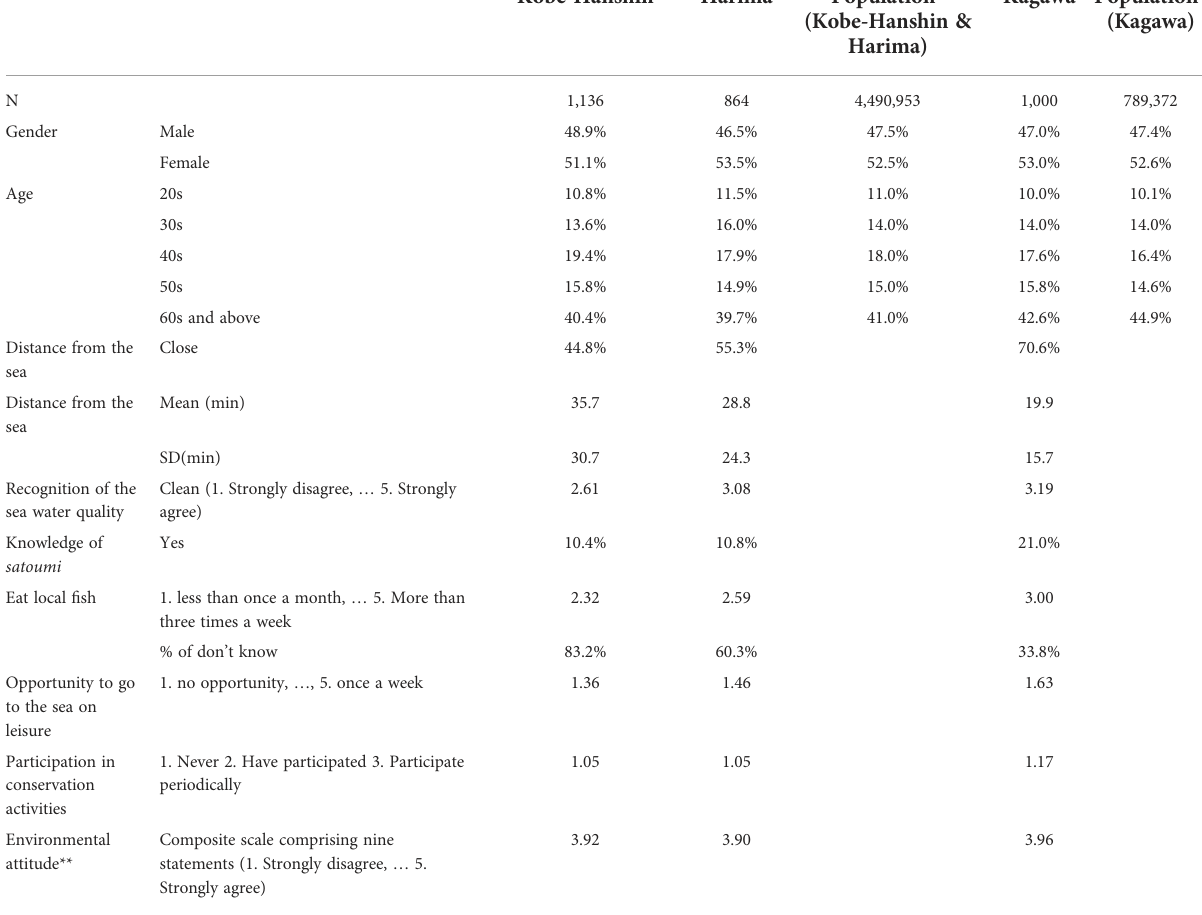
TABLE 4 Characteristics of the respondents by